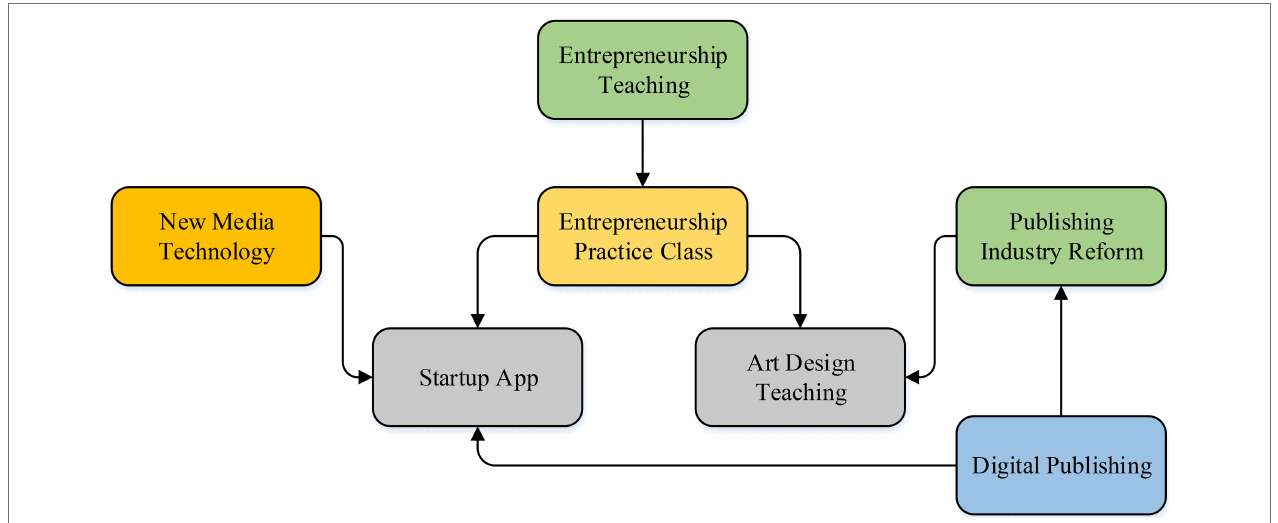
FIGURE 1 | The relationship between students’ entrepreneurship and college teaching under the new